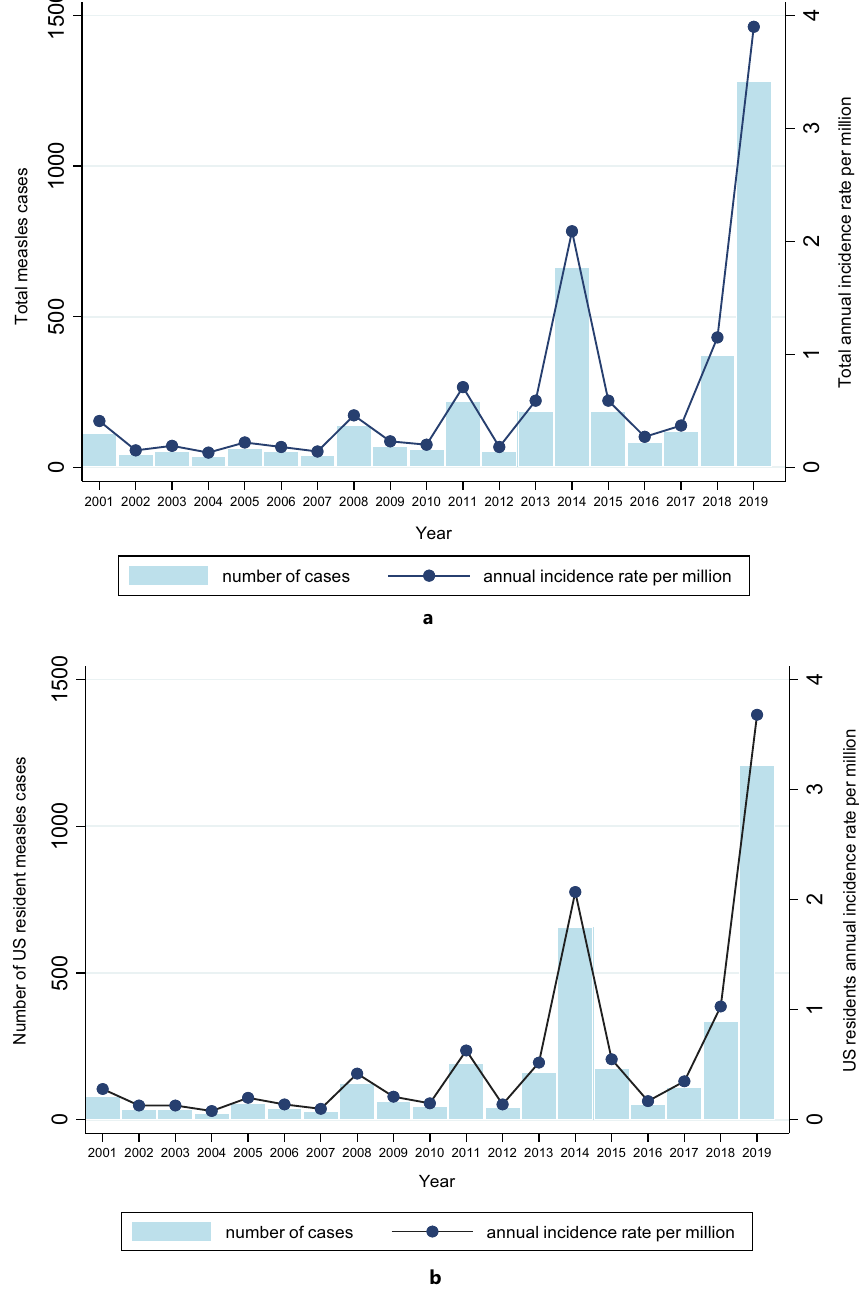
Figure 1. ( a ) Total annual incidence rate of measles and total number of measles cases between 2001 and 2019. ( b ) Annual incidence rate of measles and number of measles cases in US residents between 2001 and 2019. The light blue shading represents the number of cases and the connected line represents the annual incidence rate (AIR) per million population. The total AIR and the AIR in US residents was relatively constant between 2001 and 2013, but there were subsequent peaks in 2014 and